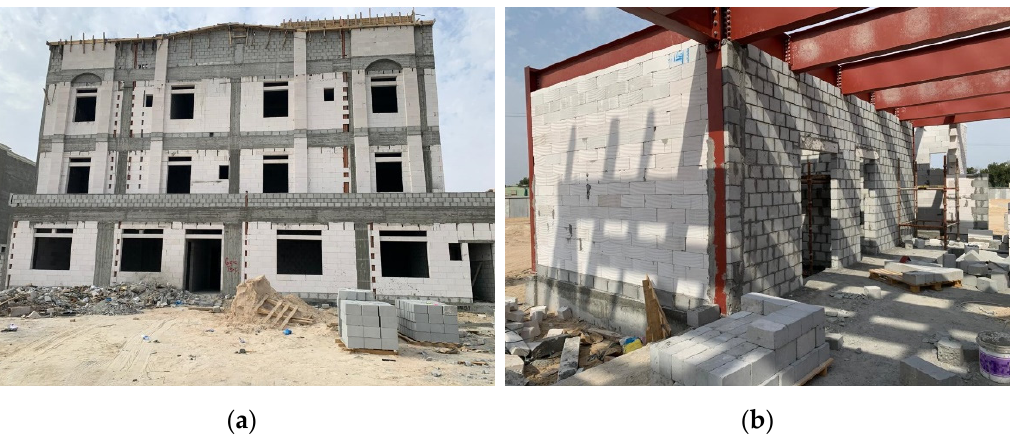
Figure 1. Skeleton buildings with exterior walls made of AAC blocks in the GCC region ( a ) with concrete skeleton, and ( b ) with steel skeleton.